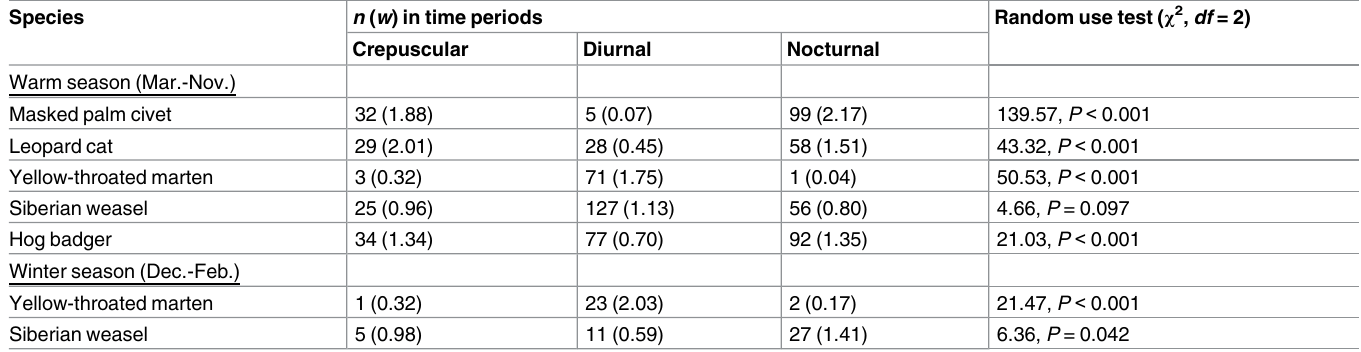
Table 4. Number of detections n (selection ratio w ) and the random use test of the crepuscular, nocturnal and diurnal periods given their avail- ability by the mesocarnivores in warm (Mar.-Nov.) and winter (Dec.-Feb.) seasons in Minshan Mountains of Sichuan, China. Species n ( w ) in time periods Random use test ( χ 2 , df = 2) Crepuscular Diurnal Nocturnal Warm season (Mar.-Nov.) Masked palm civet 32 (1.88) 139.57, P < 0.001 Leopard cat Yellow-throated marten Siberian weasel Hog badger Winter season (Dec.-Feb.) Yellow-throated marten Siberian